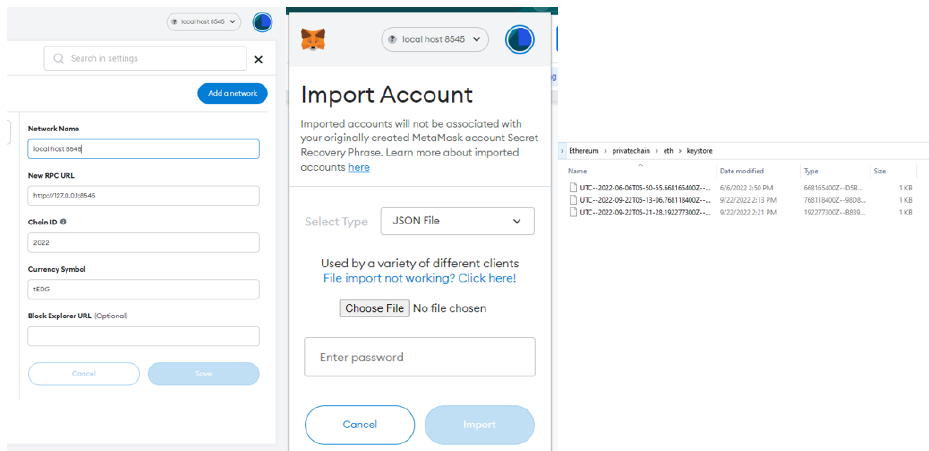
Figure 13. Importing Ethereum account in Metamask.